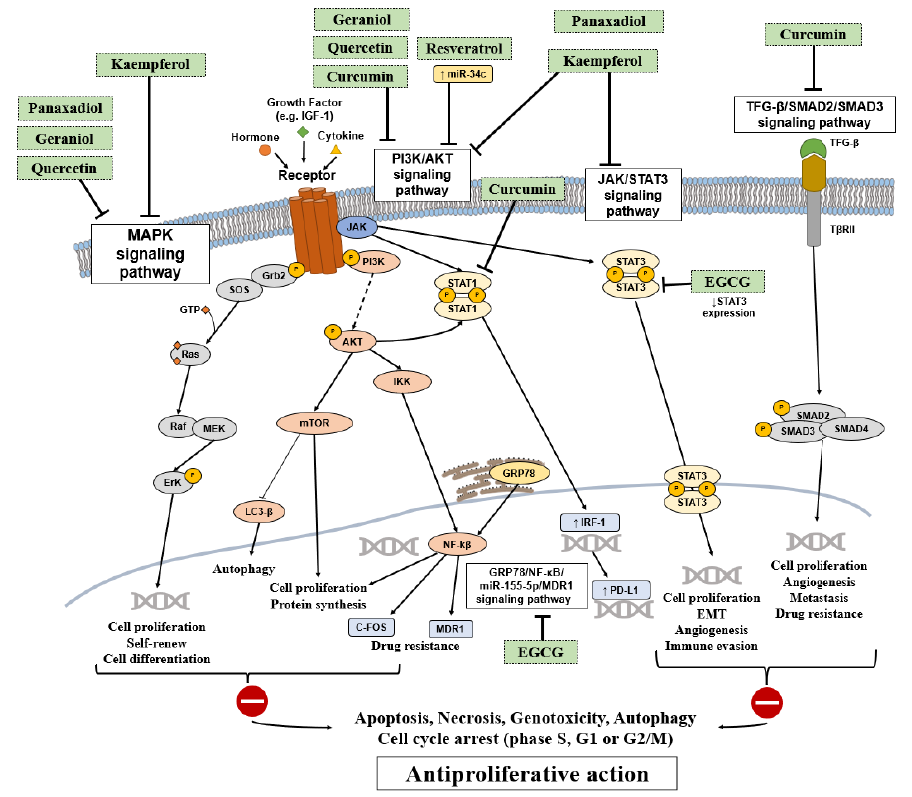
Figure 3. Main signaling pathways that were altered after treatment with several of the natural compounds that were analyzed in this review. Most pathways are linked to multidrug resistance processes and their inhibition leads to cell death processes that are induced by apoptosis, necrosis, autophagy, or mediated by genotoxicity.